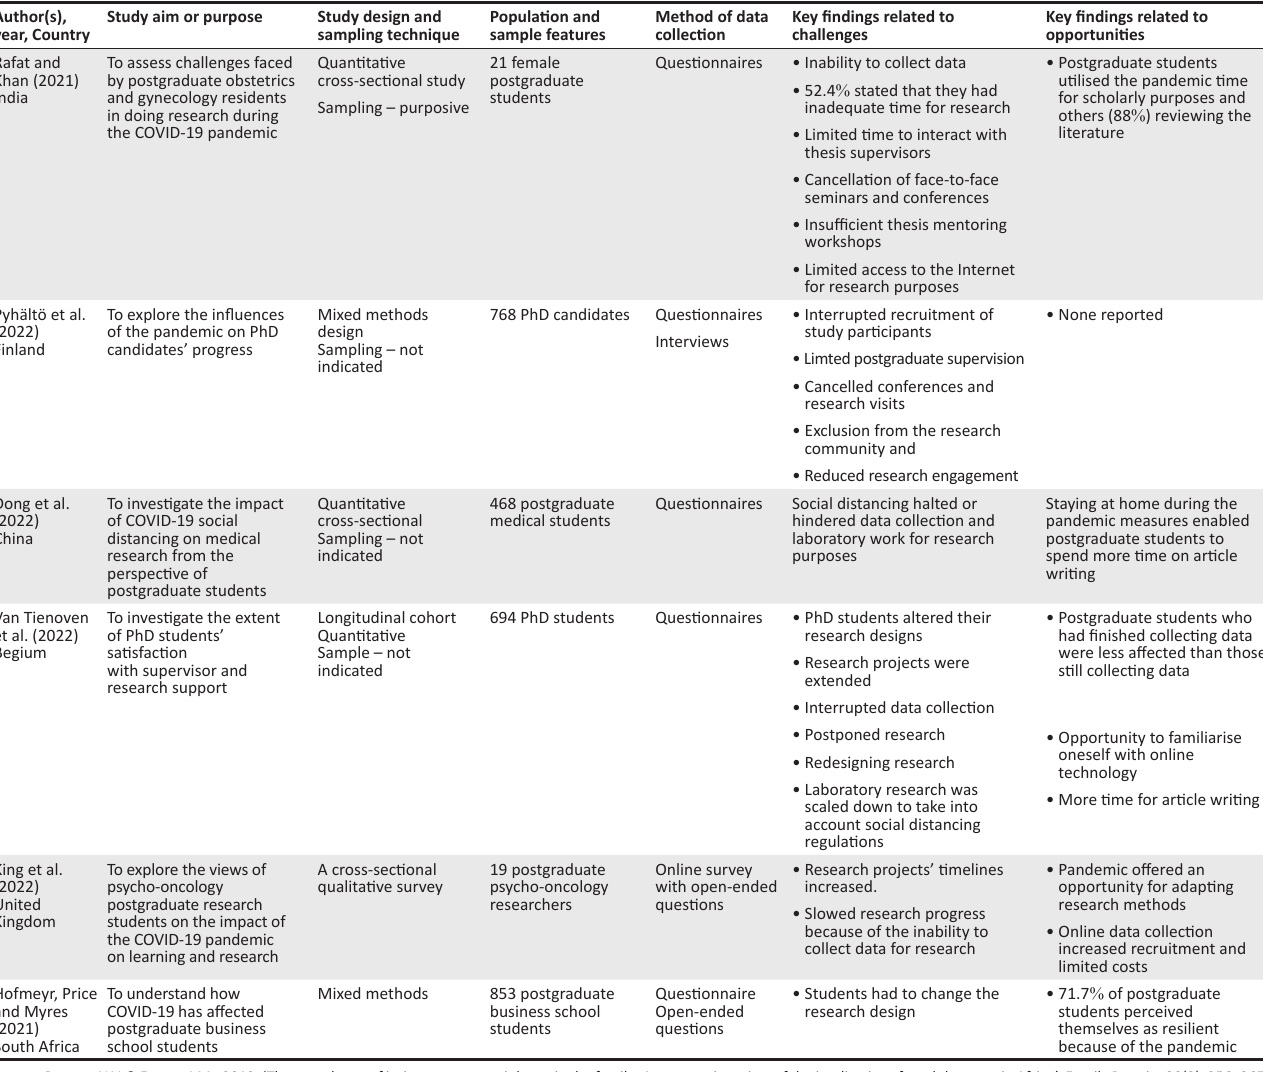
TABLE 2: Summary of studies included in the scoping review following full-text